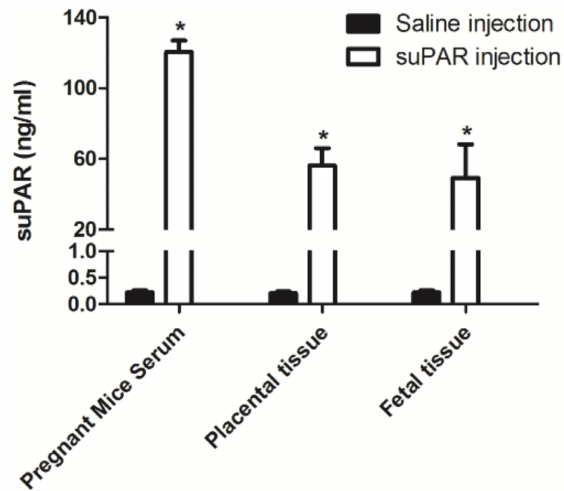
Figure 4. Maternal serum, placenta, and fetus tissue 2 hours after injection of